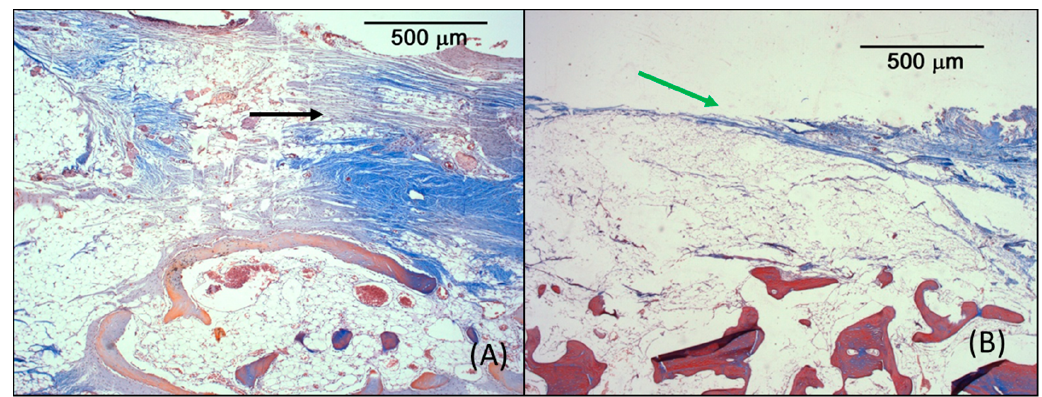
Figure 7. Microscopic images from Group 1 (control): ( A ) Connective tissue around adipose islands (black arrow). ( B ) Capsular connective tissue (green arrow).